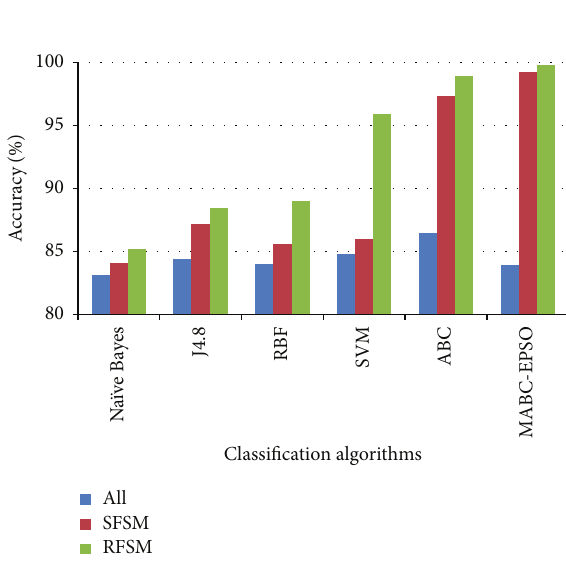
Figure 4: Accuracy comparison of classifiers for probe dataset.